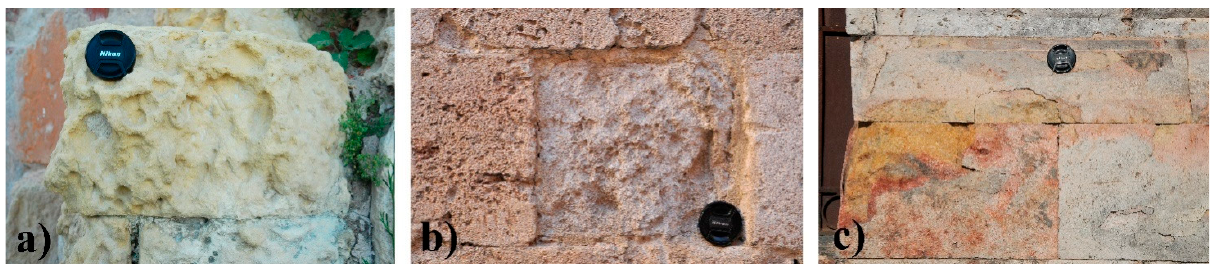
Figure 3. Degradation forms of the Calcari di Cagliari used as building materials: ( a ) Alveolization of an ashlar of Pietra Cantone; ( b ) loss of material due to pulverization and detachment in an ashlar of Tramezzario; ( c ) fractures, oxidation, and detachments in a wall built with Pietra Forte ashlars.